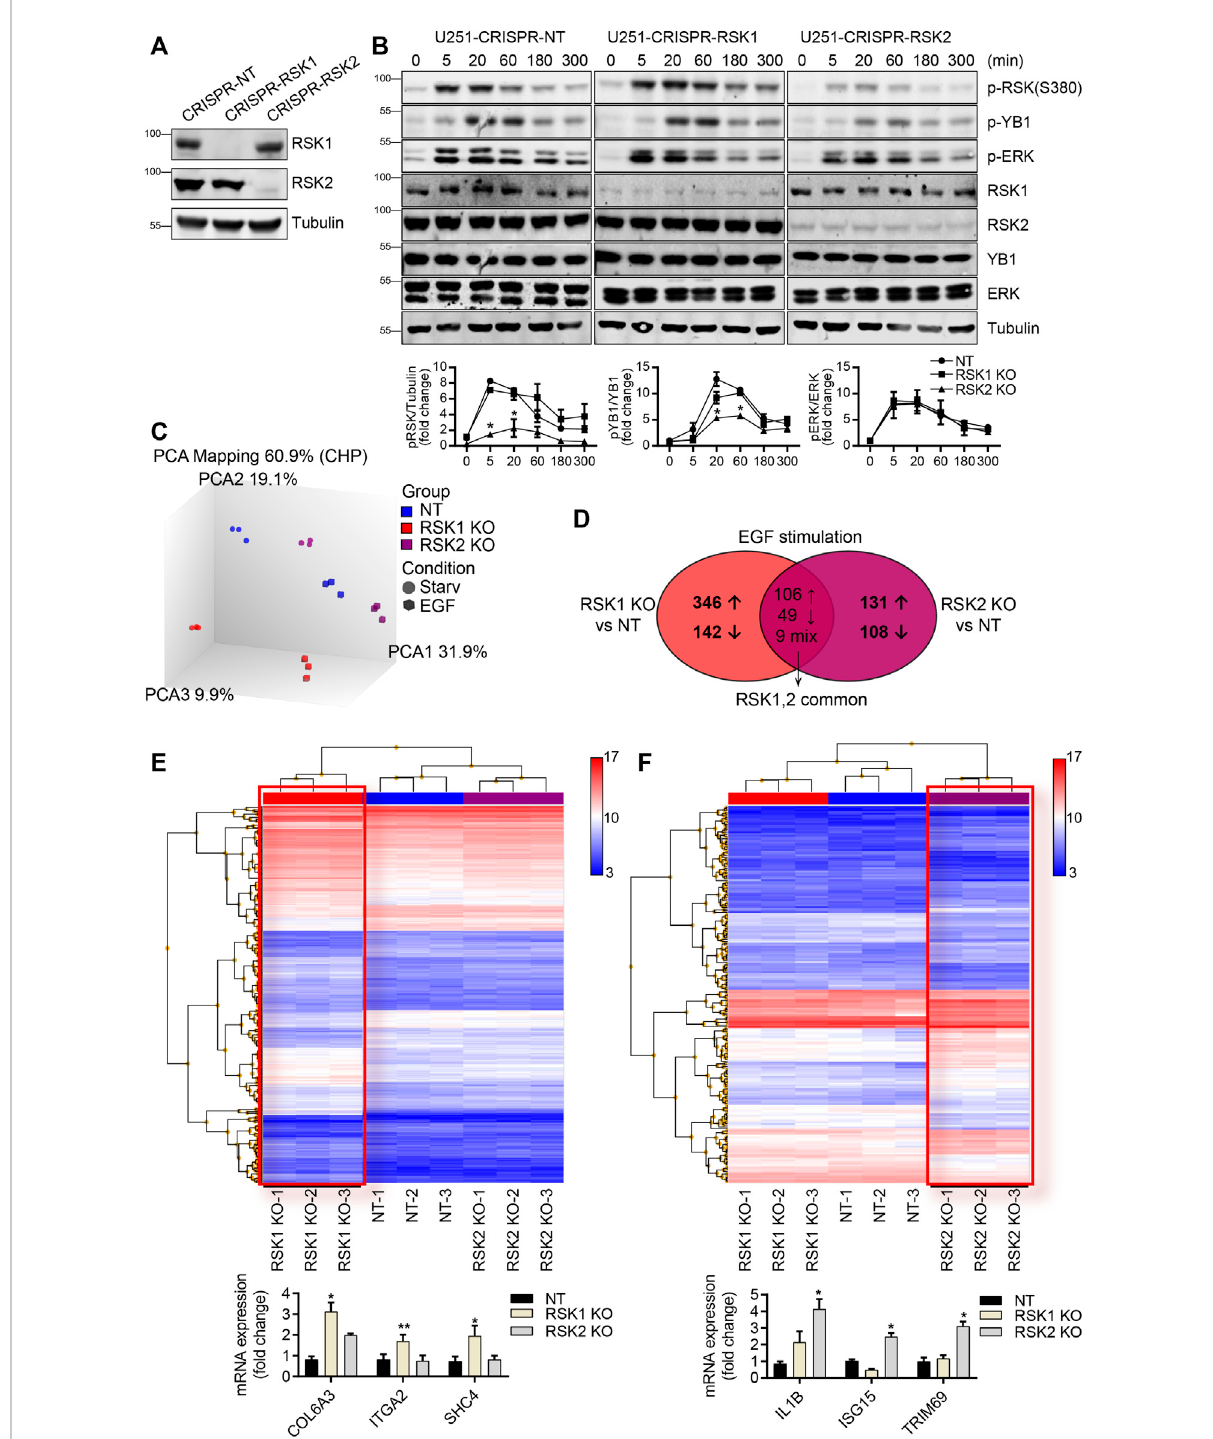
CRISPR/Cas9mediatedknockoutofRSK1andRSK2formicroarrayanalysis. (A) Stableknockout(KO)celllinesofRSK1andRSK2werecon fi rmed by Western blotting. (B) Western blotting with indicated proteins after 100 ng/ml EGF treatment for 0, 5, 20, 60, 180, and 300 min. Each cell line was cultured in reduced serum (0.1% FBS) overnight. Tubulin was used as a loading control. Expression intensity of p-RSK, p-YB1 and p-ERK were quanti fi ed using ImageJ (bottom). (C) Principal component analysis (PCA) plot of overall mRNA expression data characterizing the entire transcriptional pro fi le of the enrolled samples, generated using Transcriptome Analysis Console (TAC) software. (D) Venn diagram illustration of the